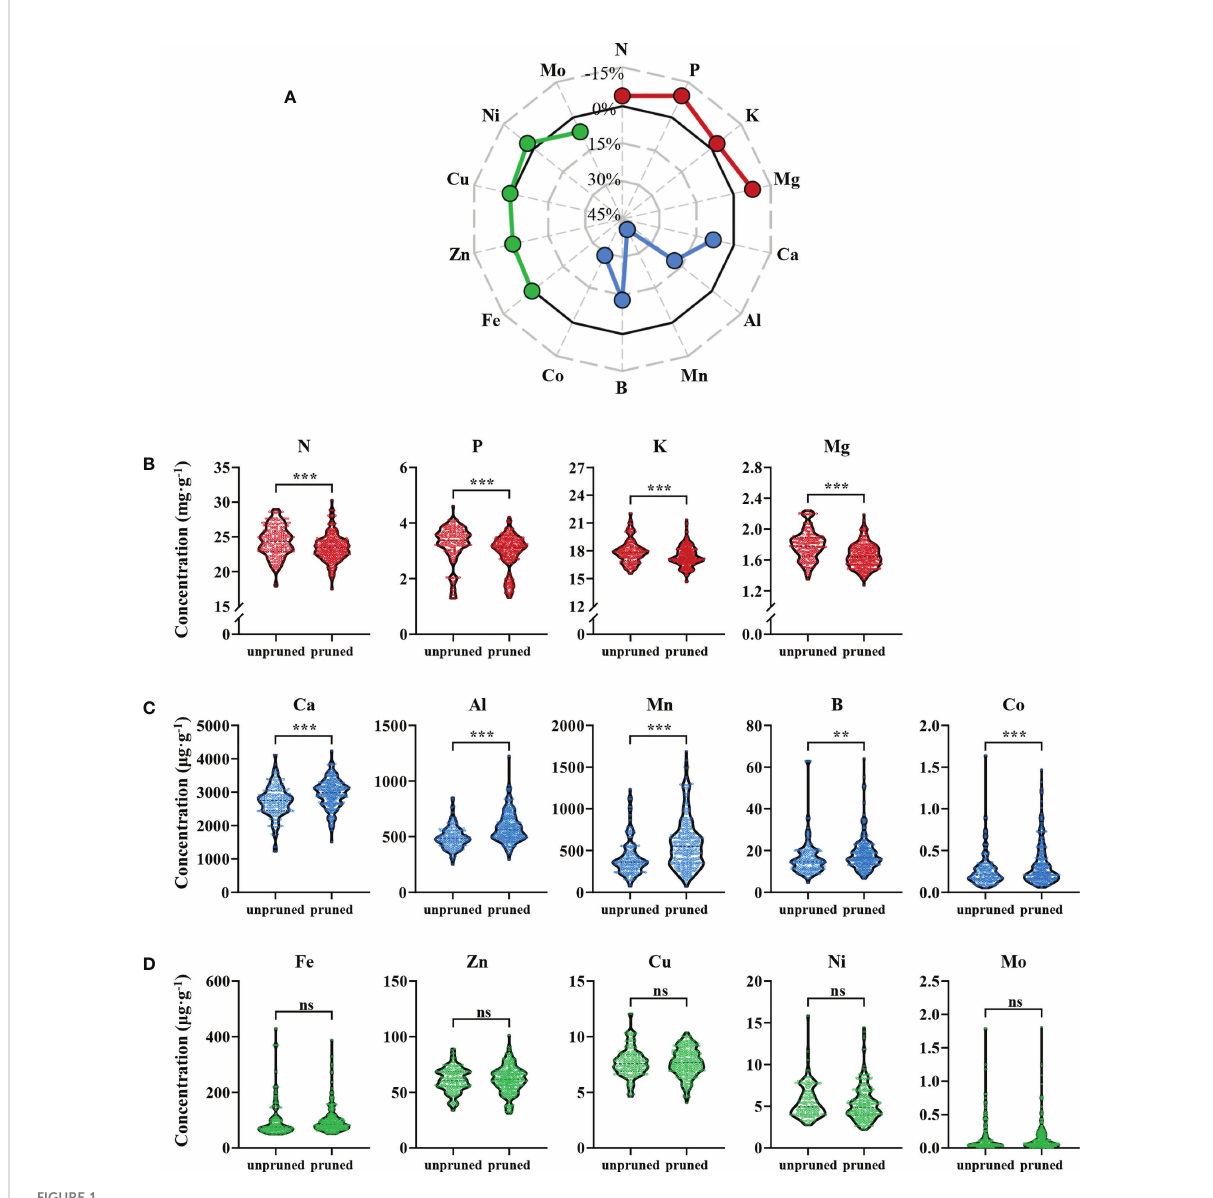
FIGURE 1 Ionomic analysis of fresh tea leaves from pruned and unpruned tea plants. (A) Percentage changes in mineral element concentrations with pruning. Percentage change = [(concentration pruned - concentration unpruned )/concentration unpruned ]×100%. Elements with concentrations that decreased (B) , increased (C) and did not change signi fi cantly (D) in fresh tea leaves from pruned tea plants. Values in the fi gure are the mean of 7 replicate samples per tea plantation (unpruned: n=132, pruned: n=218). Statistically signi fi cant differences between groups were tested by the Student ’ s t test. ***: P ≤ 0.001, **: 0.001 < P ≤ 0.01, ns, no signi fi cant